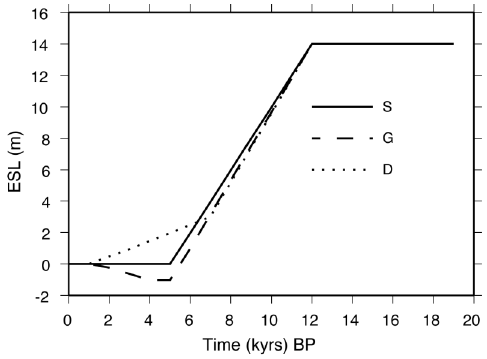
Fig. 9. Time-histories of ESL for the Antarctic component of ICE3G according to the S, G, and D models described in the text. They are constituted by a simple disc-shaped ice element that stores an ESL of 14 m before the beginning of melting (12 kyrs BP). Predictions for modified ICE3G chronologies including these Antarctic components are shown in fig. 11 and